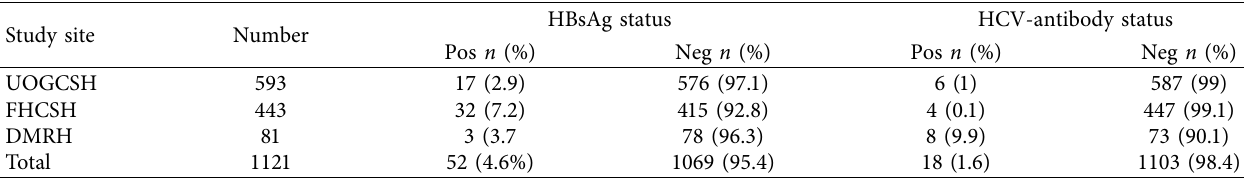
Table 2: Seroprevalence of HBsAg and anti-HCV antibody among pregnant women in the Amhara National Regional State in three tertiary hospitals from May 1, 2018, to September 30, 2019 ( n �